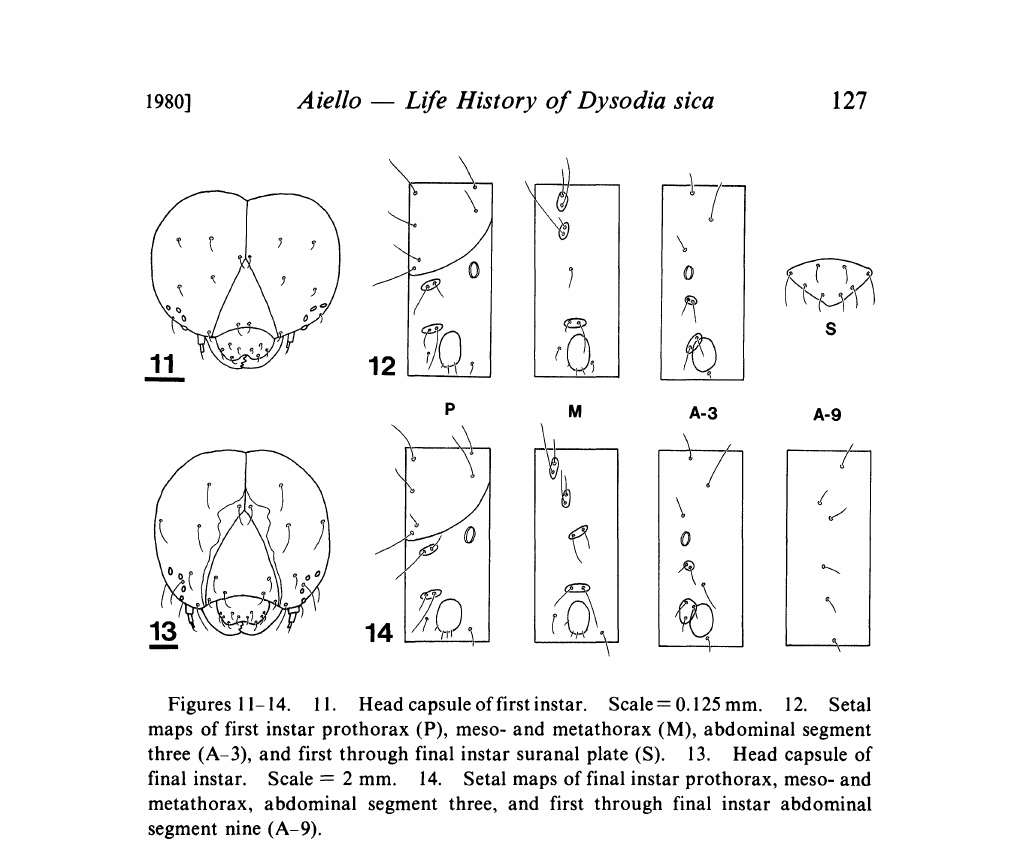
three (A-3), and first through final instar suranal plate (S). 13. Head capsule of final instar. Scale 2 mm. 14. Setal maps of final instar prothorax, meso- and metathorax, abdominal segment three, and first through final instar abdominal segment nine